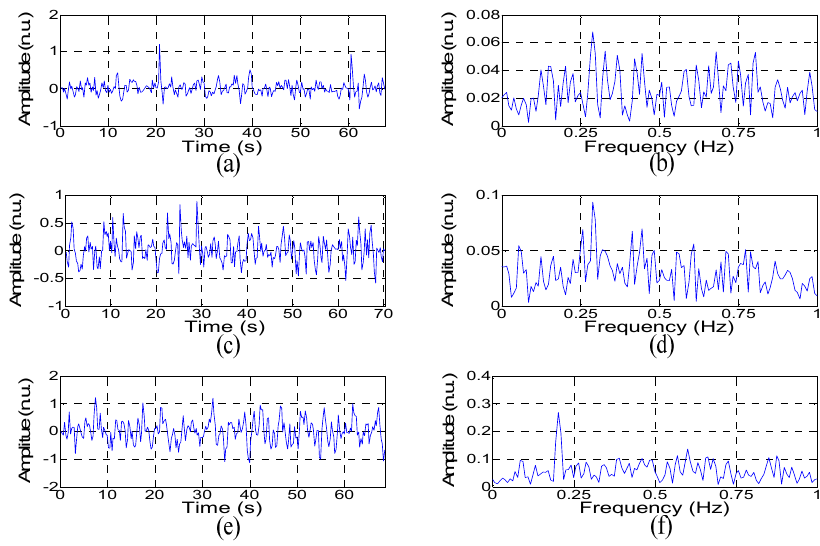
Figure 14. Detection results of the artificial breathing object (left column) and their corresponding power spectrum (right column) with different antenna deployments: ( a , b ) the transmitting and receiving antennas were placed close together; ( c , d ) the transmitting and receiving antennas were placed separately; and ( e , f ) the transmitting antenna was moving away from the receiving ones.